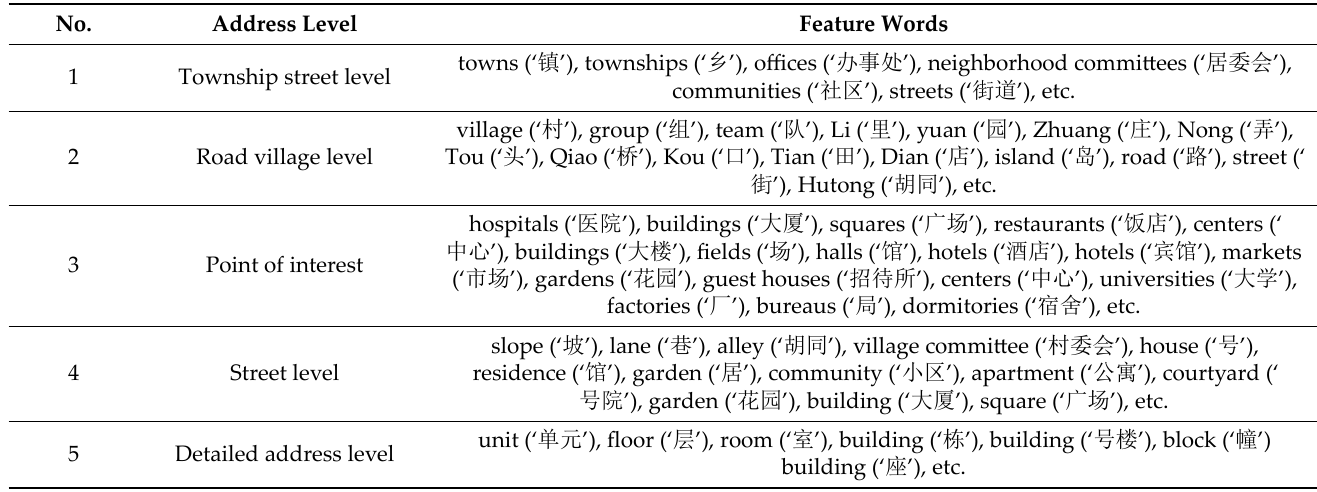
Table 3. Exact address feature words in Weibo